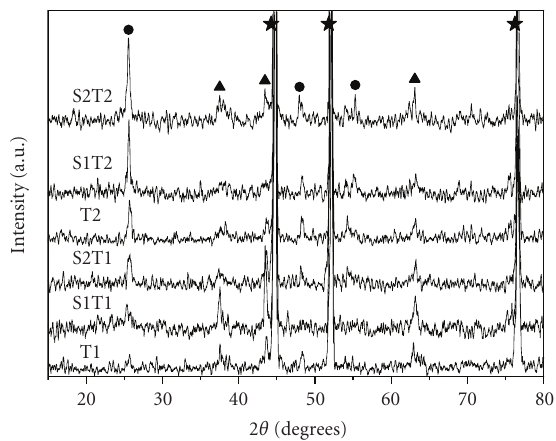
Figure 5: XRD patterns of T1, S1T1, S2T1, T2, S1T2, and S2T2. (Symbol: • —anatase TiO 2 , (cid:2) —NiO, (cid:2) —Ni.)